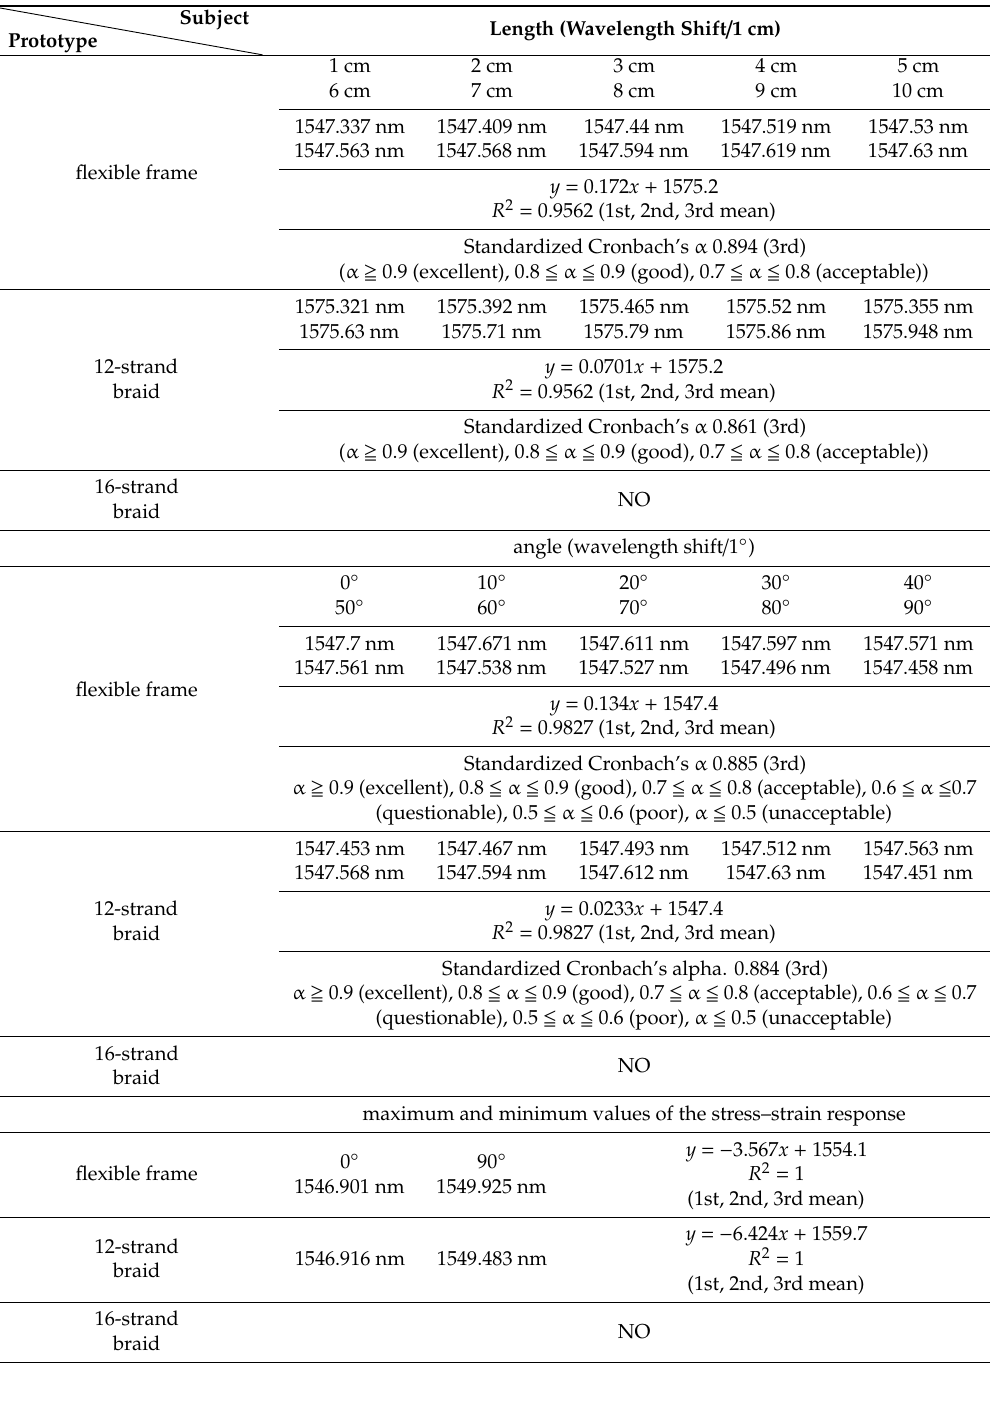
Table 2. The data for the three prototypes investigated (length, angle, maximum and minimum values, confidence constant—Cronbach’s α